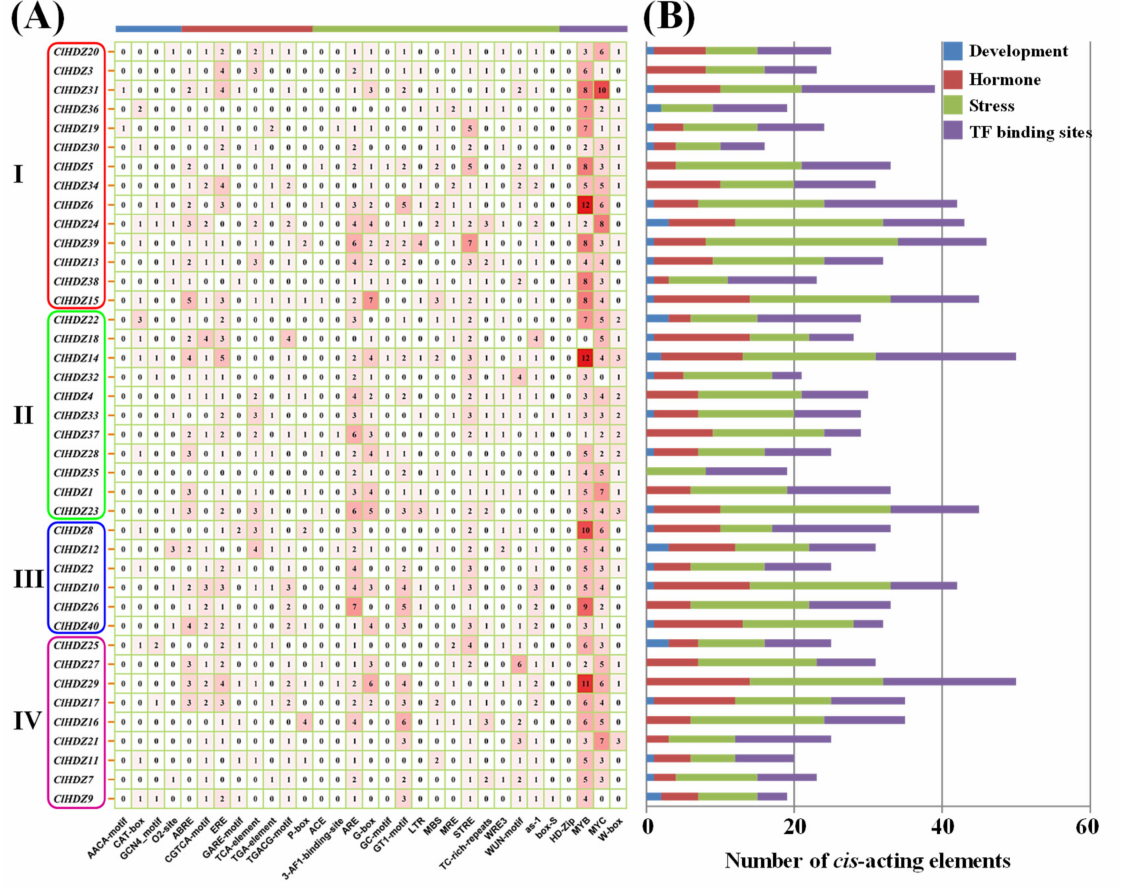
Figure 4. The prediction of cis-elements in promoter regions of ClHDZs . The detailed numbers ( A ) and statistical graphs ( B ) are presented,